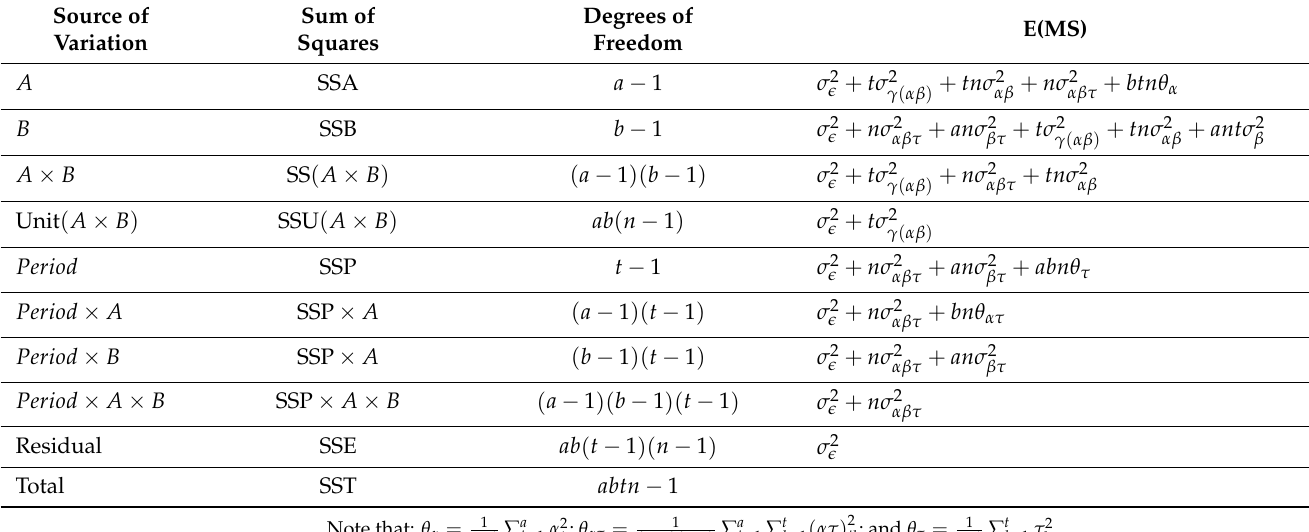
Table 2. Expected mean squares for a three-factor repeated-measures